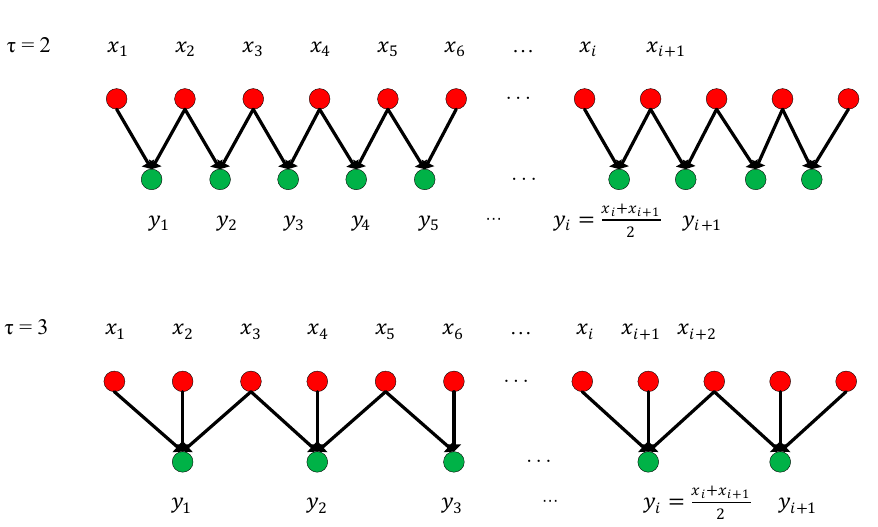
Figure 10. Improved time series coarsening for scales 2 and 3.